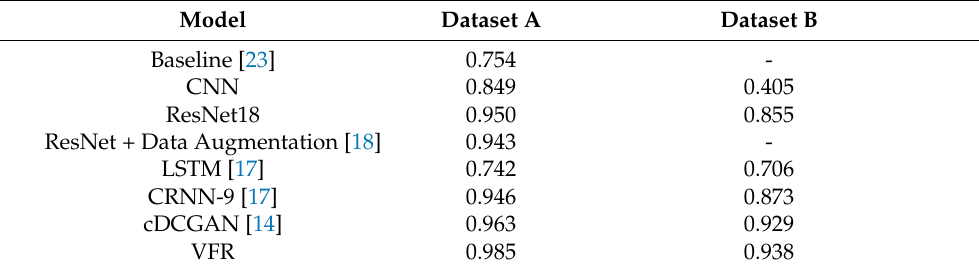
Table 5. The accuracy of different models.